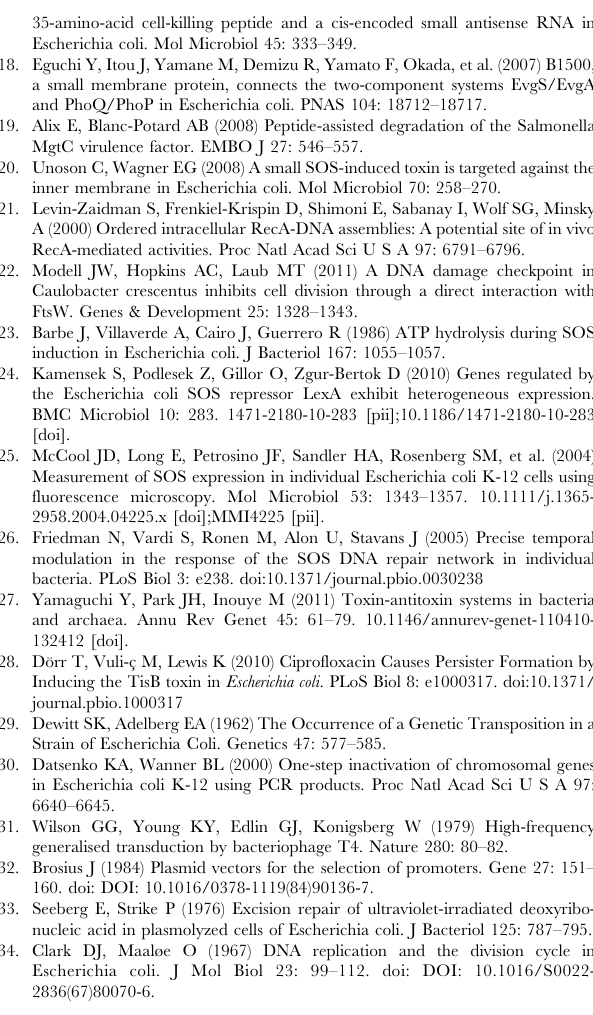
Figure S4 Filamentation. Fluorescence microscopy of UV exposed (50 J/m 2 ) strains as indicated followed by growth for 1 and 2.5 h. Cells were grown in K-medium and stained with acridine orange. Each image is quantified and median values in m m are given together with number of cells measured (in parentheses). Figure S5 Survival of ( dinQ,recB ) and ( dinQ, uvrA ) mutants. Serially diluted Serially diluted (10 2 1 –10 2 5 cells ml 2 1 ) log phase cultures of wt (AB1157), D dinQ (BK4140), uvrA::kan (BK4180), D dinQ,uvrA (BK4141), recB::kan (BK4110) or D dinQ,recB::kan (BK4142) were spotted onto LB plates and exposed to 4 J/m 2 (right panel), unexposed panels to the left. Pictures were taken 1 day after incubation at 37 u C. Table S1 Characteristics of bacterial strains and plasmids used in this study.